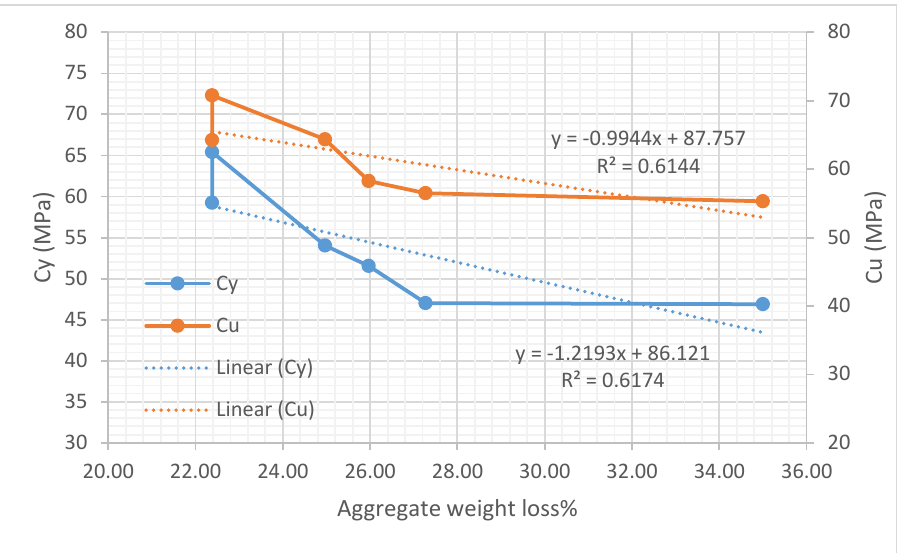
Figure 9. Correlation between compressive strength and aggregate strength.